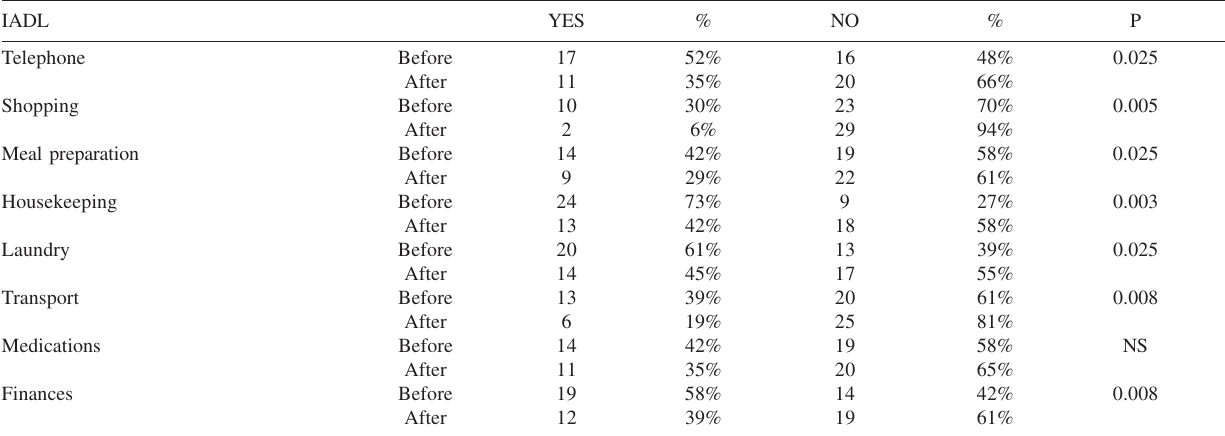
Table 6 - IADL in patients before and after hip fracture IADL Telephone